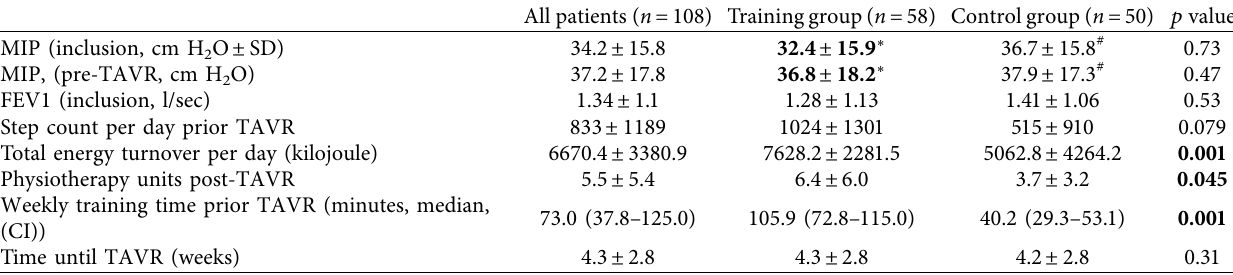
Table 2: Respiratory, mobility, and training